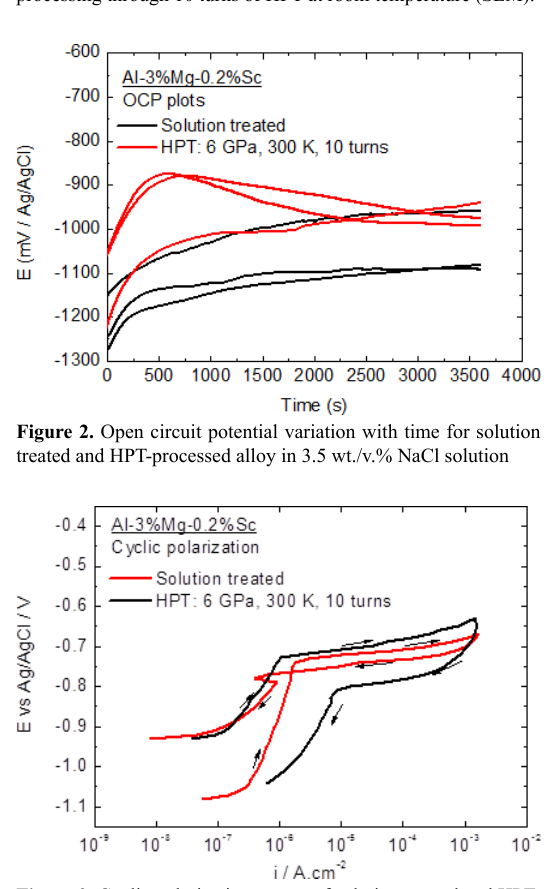
Figure 3. Cyclic polarization curves of solution treated and HPT- processed alloy in 3.5 wt./v.% NaCl solution Table 1. Cyclic polarization results of the different samples in 3.5 wt./v.% NaCl solution